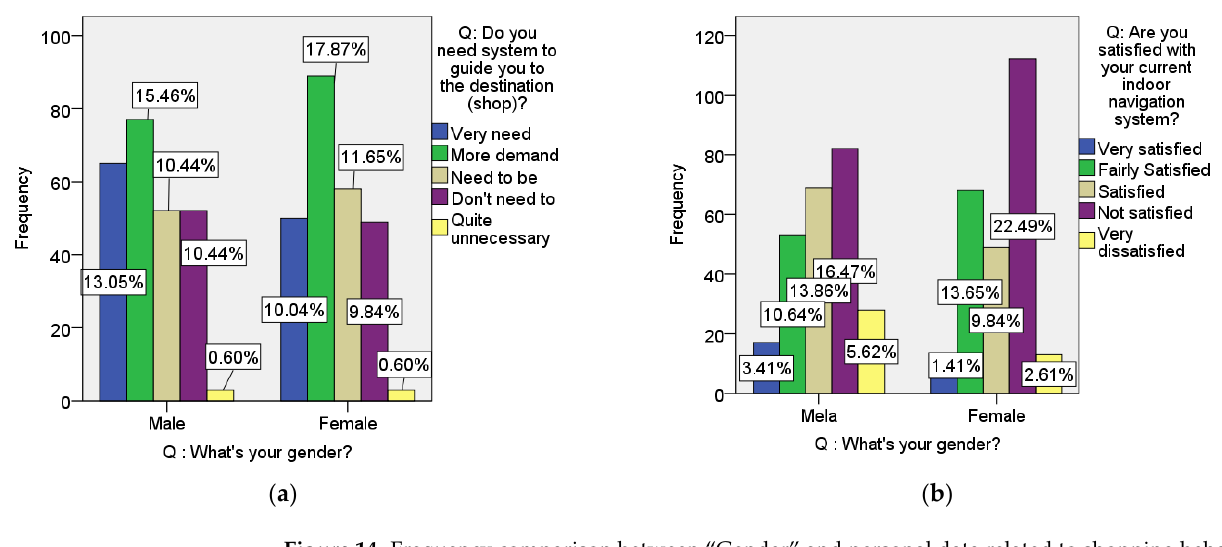
Figure 14. Frequency comparison between “Gender” and personal data related to shopping behavior. ( a ) Do you need a software system to guide you to the destination store? ( b ) Are you satisfied with the current signage/system for indoor navigation?